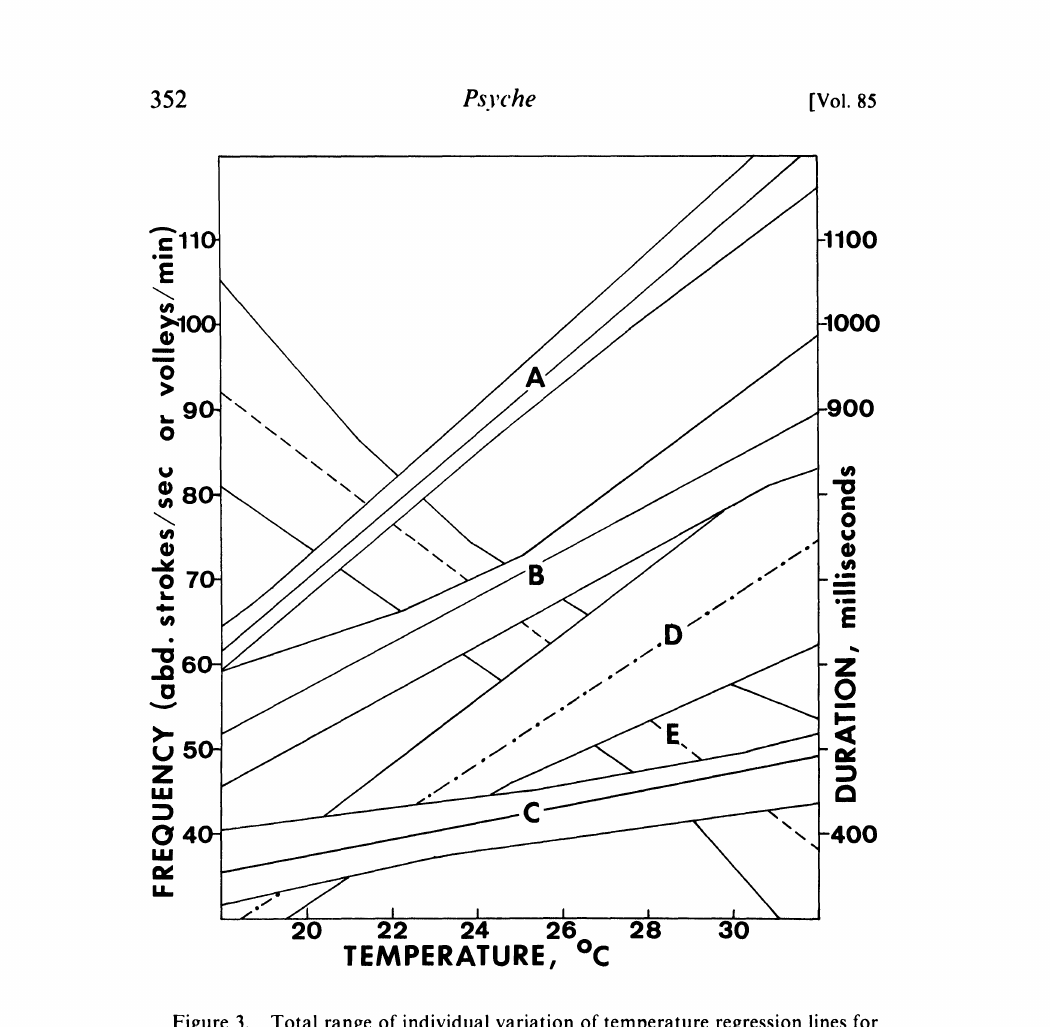
Figure 3. Total range of individual variation of temperature regression lines for the five major call characteristics A-E of Ch. plorabunda. The area above and below each straight line includes within it the linear regresssions for all 10 individuals tested, while the line itself summarizes temperature data for those 10 insects in a single regression equation. Axes and labels as in Fig. 2. -= A: y 4.27x 15.37,